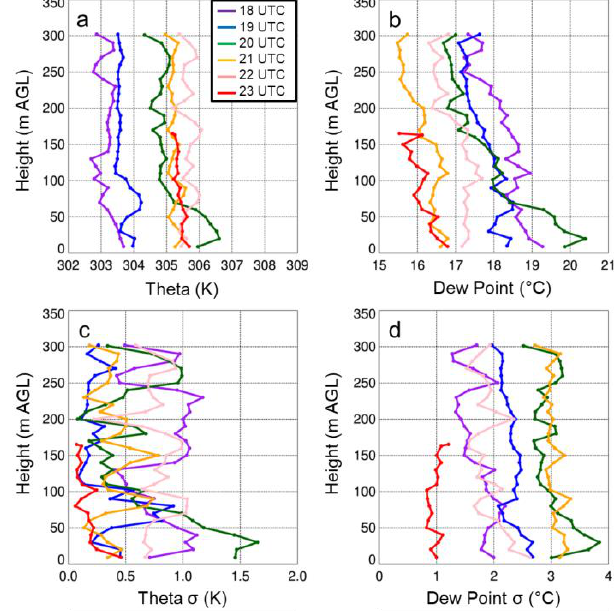
with Figure 13. Vertical profiles of potential temperature ( a ) and dew point ( b ) as a function of height for select sUAS flights with the DJI S-1000 on 17 August 2017. Panels ( c ) and ( d ) show the standard deviation in potential temperature and dew point, respectively. Purple, blue, green, orange, pink, and red lines coincide with flights made starting at 1810 UTC, 1910 UTC, 2010 UTC, 2110 UTC, 2210 UTC, and 2310 UTC, respectively. Data were binned every 10-m